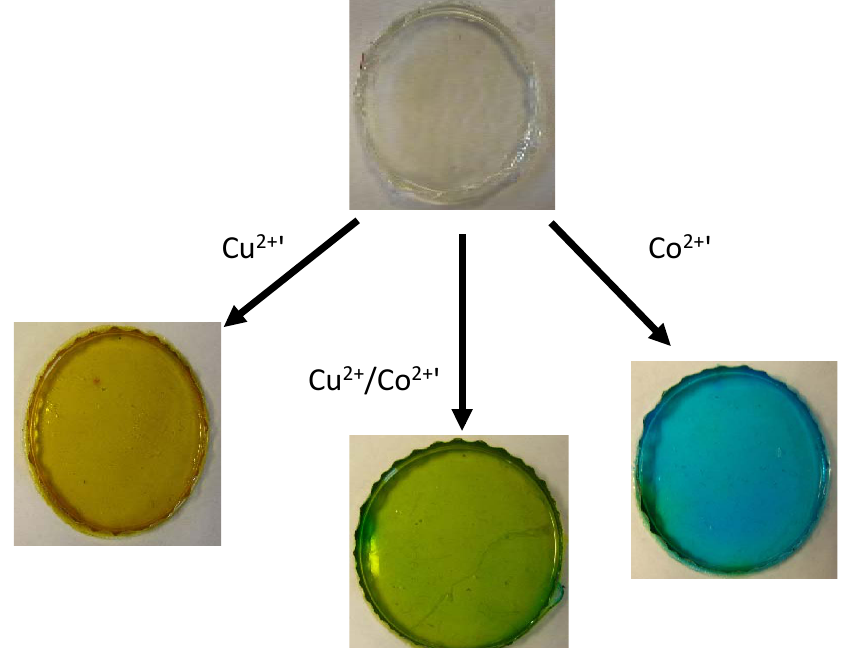
Figure 7. Optical response of trihexyltetradecylphosphonium dicyanamide ([P poly(vinylchloride) (PVC) based ionogel upon complexation with Cu 2+ (yellow, left), Co 2+ (blue, right), and a mixture of the two (green, middle)